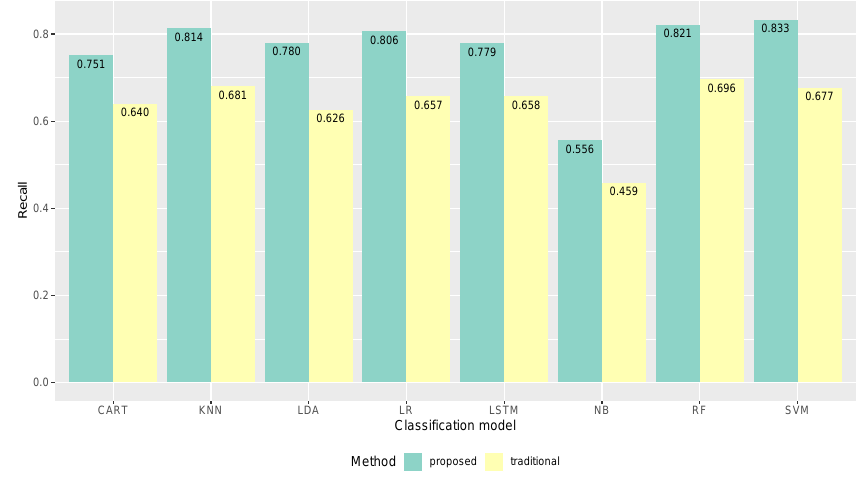
Figure 12. The recall performance results of several machine learning